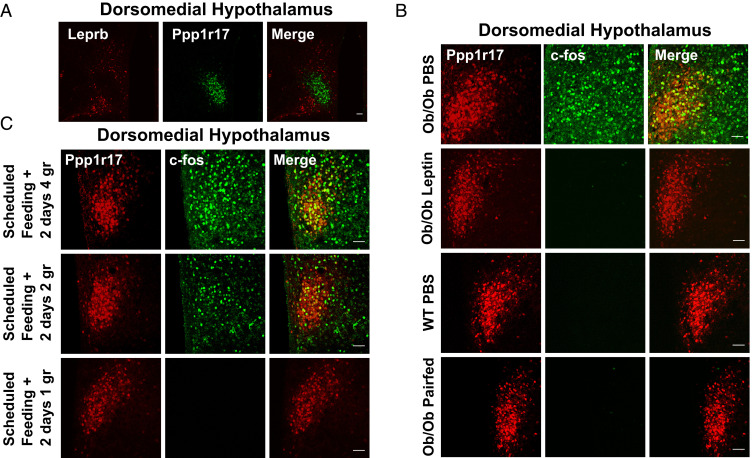
cFos expression in Ppp1r17 neurons in ob mice and during scheduled feeding. (A) IHC for Ppp1r17 and TdTomato in ObRb TdTomato mice. DMHPpp1r17 neurons do not express Leprb. (B) cFos expression in DMHPpp1r17 neurons in ob/ob mice is reduced by 14 d pair-feeding. (C) cFos expression in DMHPpp1r17 neurons in scheduled feeding during the 3-h feeding window in response to different amounts of chow. Food is provided to mice between Circadian Time (CT)4 and CT7: (Upper) 4 g of food, the amount normally consumed during the 3-h feeding window; (Middle) 2 g of food, the amount mice consume in 3 h after a fast; and (Lower) 1 g, the amount consumed during the dark phase within 3 h. (Scale bars, 50 μm.)